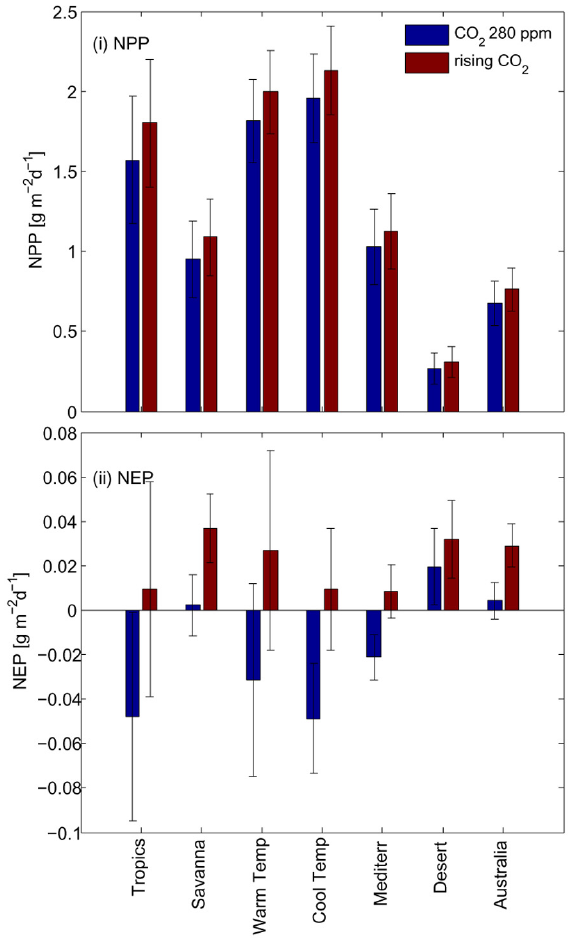
Fig. 8. (i) BIOS2 estimates of 1990–2011 mean NPP under pre- industrial CO 2 and increasing CO 2 forcing. (ii) BIOS2 estimates of 1990–2011 mean NEP under pre-industrial CO 2 and rising CO 2 . Error bars represent 1 σ uncertainties on the mean, and include con- tributions from parameter uncertainties and forcing uncertainties, as evaluated in Haverd et al. (2012).